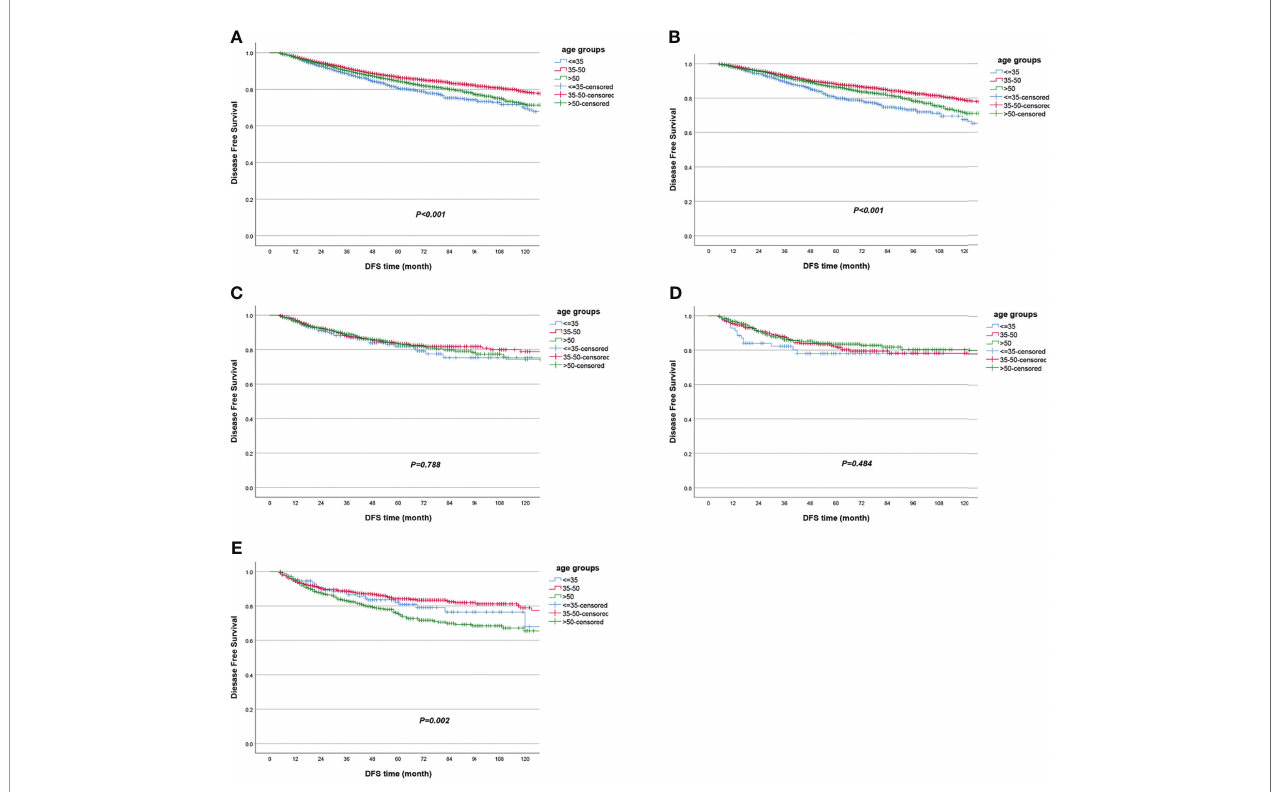
FIGURE 3 | Disease-free survival according to age groups in (A) all patients and in subgroup analyses strati fi ed by (B) HR+/HER2 − , (C) HR+/HER2+, (D) HR − /HER2+, and (E) triple